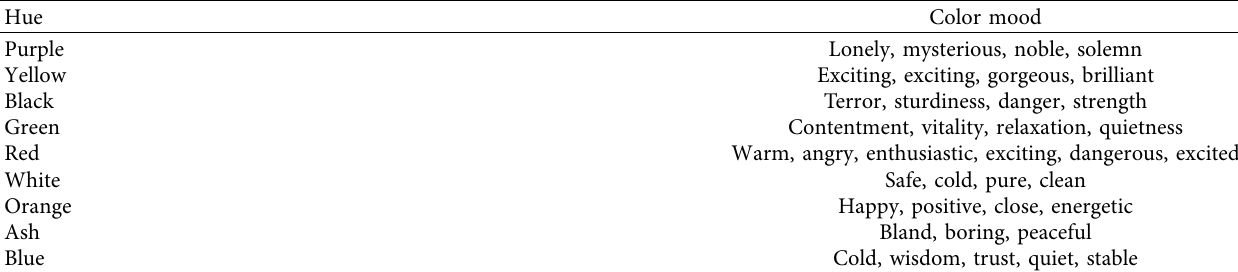
Table 2: Emotional expression of different